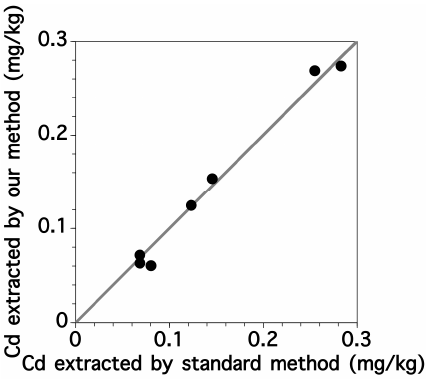
Figure 3. Relationship between Cd concentrations extracted by the standard (ICP-OES) and our developed methods.